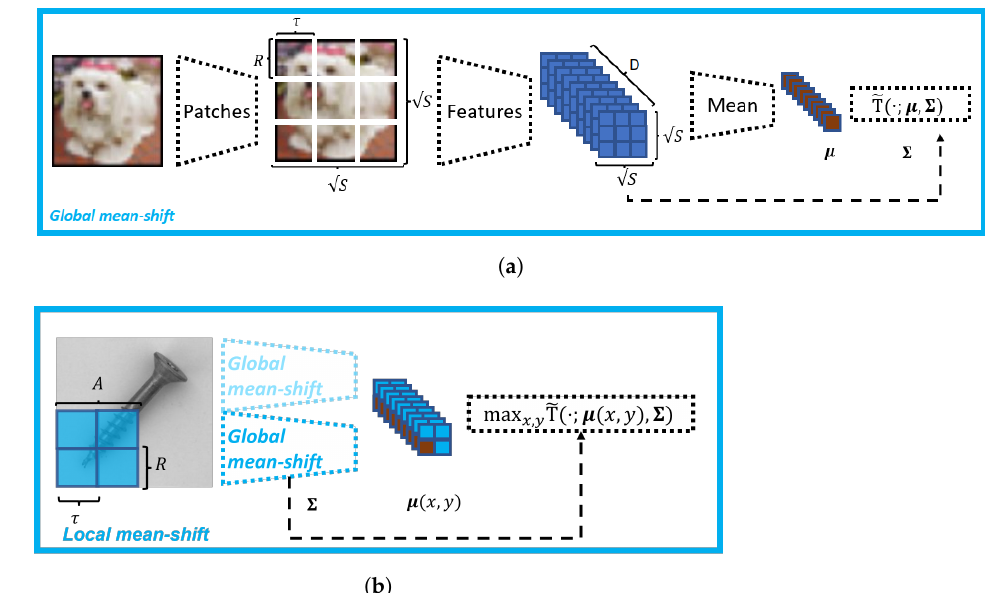
Figure 2. Schematic illustration of our mean-shift method. ( a ) First, the feature map Φ is computed per extracted image patch, then the mean statistics is computed over all training patches. Together with the empirical covariance matrix of the normal data, the Hotelling T 2 test is used as anomaly score. ( b ) The local mean-shift variant applies the global mean-shift method to a local region A of the image, and, hence, yields a field of mean vectors µ ( x , y ) . The final score is computed by taking the maximum over the field of local scores. The covariance matrix is shared across all local